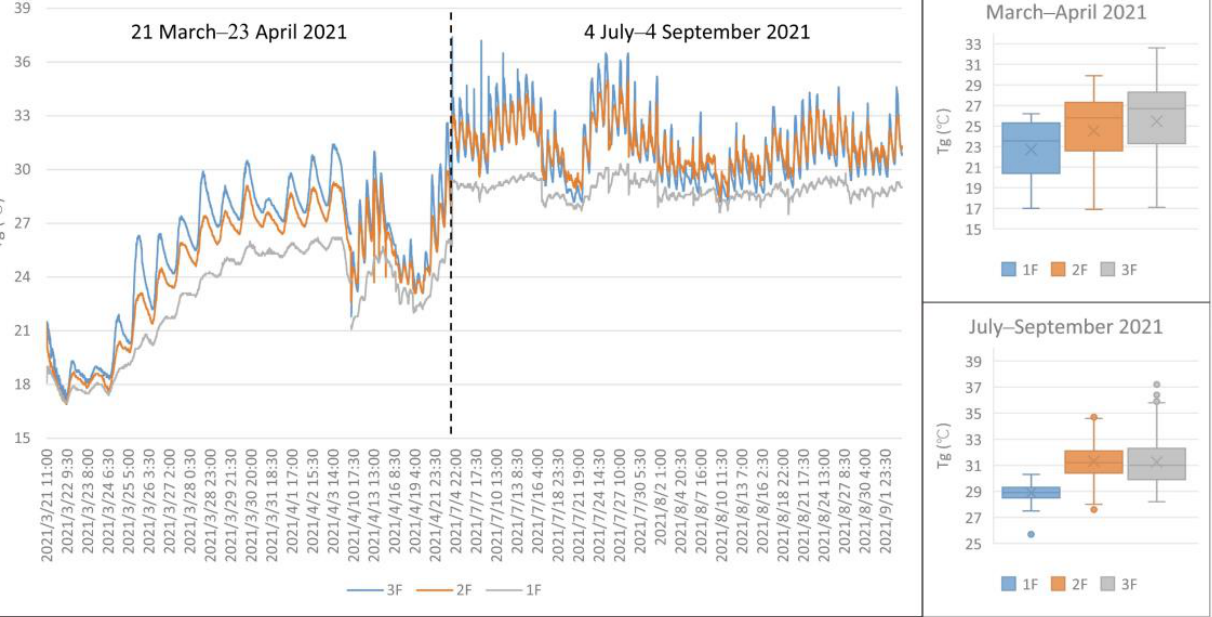
Figure 16. Tg measurement data (March – September 2021), drawn by the students.